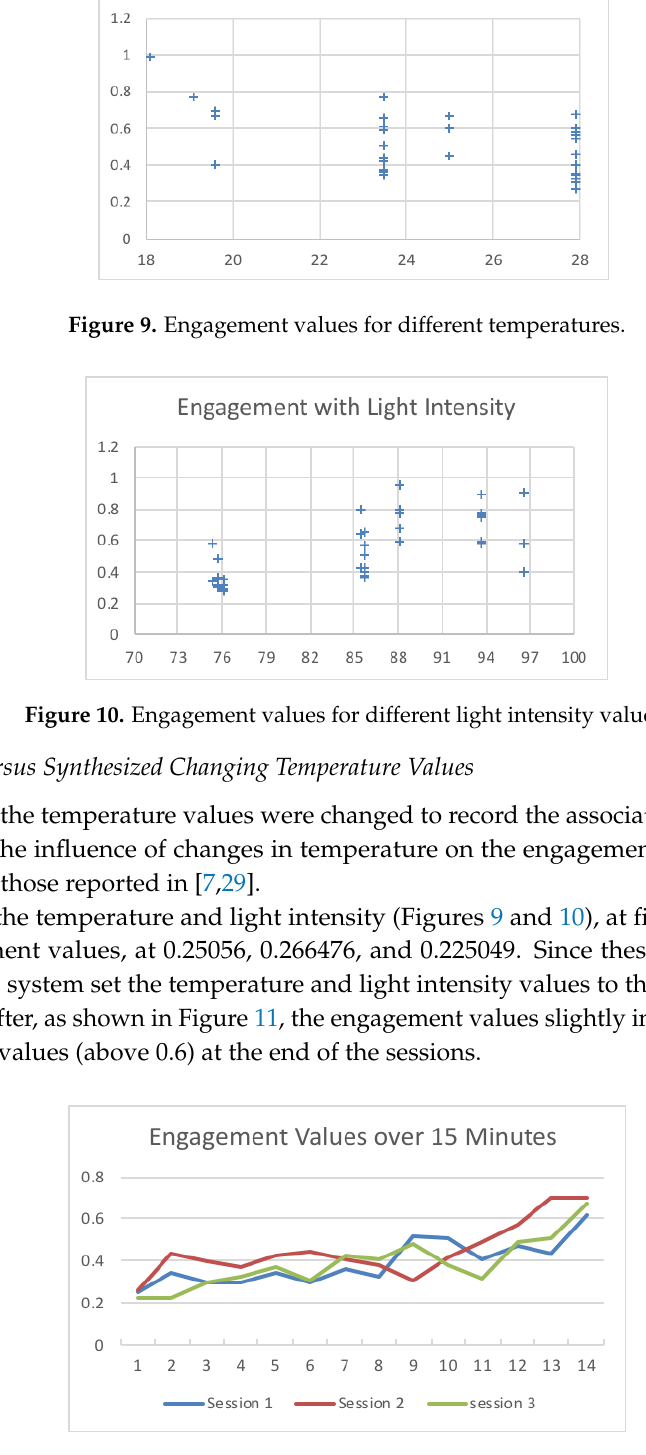
Figure 11. Engagement values over 15